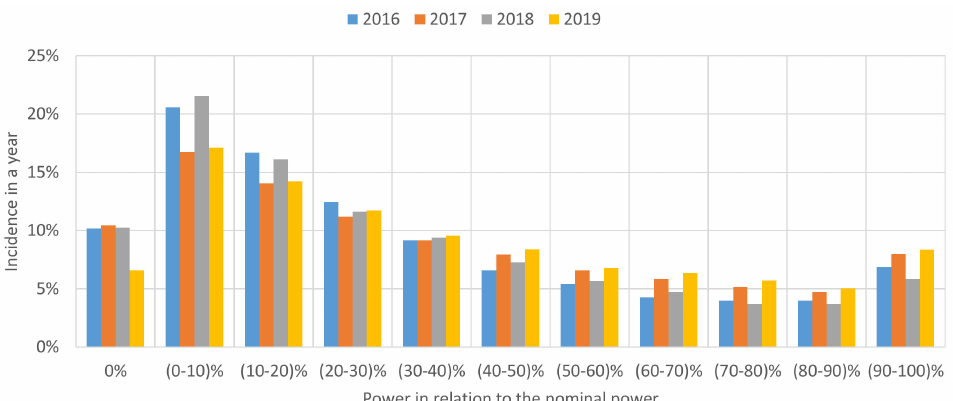
Figure 11. Percentage incidence of relative power generated for the wind farm.